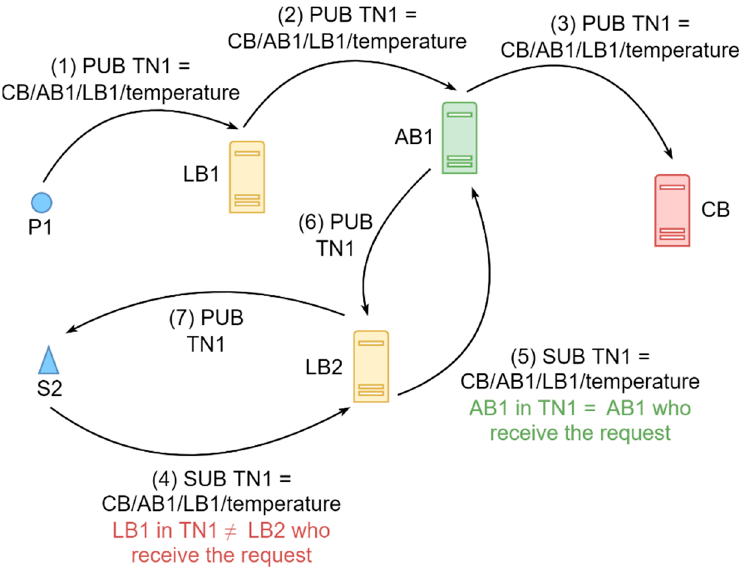
Figure 4. Second communication scenario.